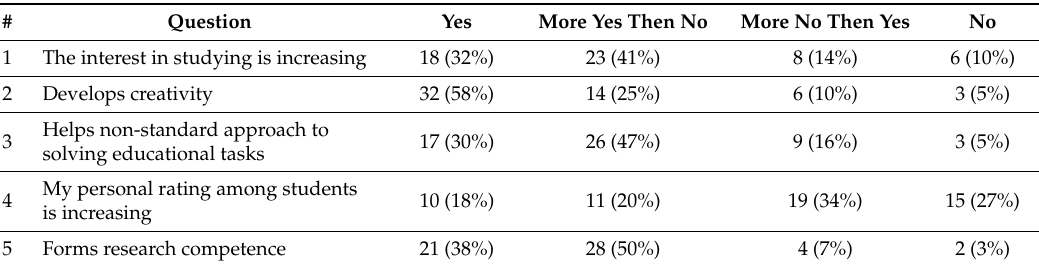
Figure 2. To what educational level should you apply research-based training elements (bachelor only, master only, both)? Table 4. What motivates you to apply research-based training elements? (estimate each of the proposed variants on the